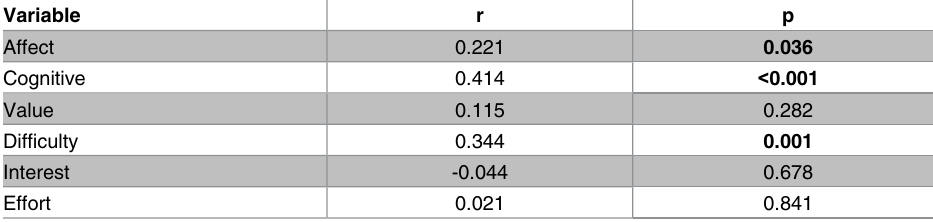
Table 4. Correlations between the attitude components scores and statistics achievement (n =